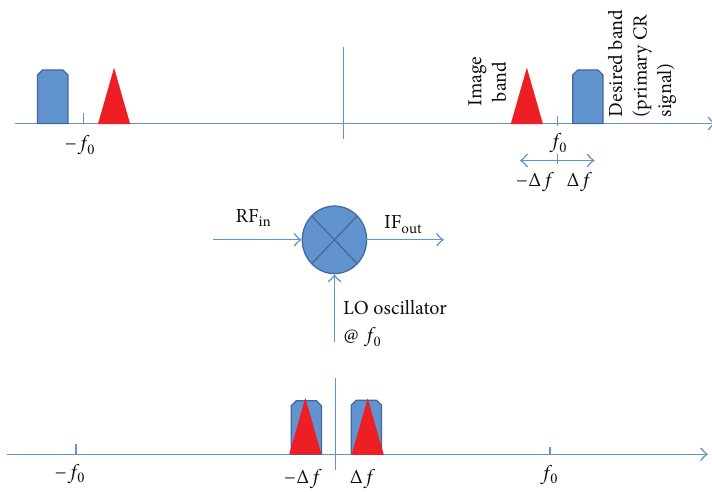
Figure 12: Example of even-order distortion in spectrum sensing receivers due to image bands.